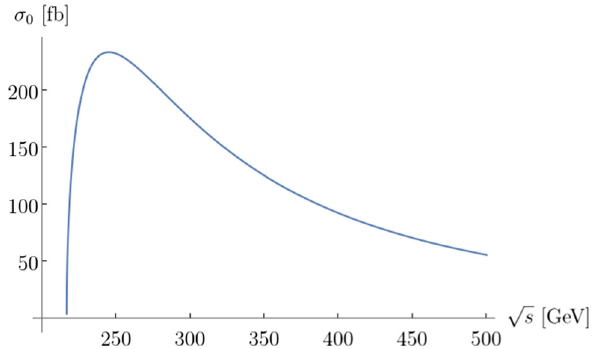
Fig. 1 The tree-level cross section for the Higgsstrahlung process in the SM as a function of the centre-of-mass energy